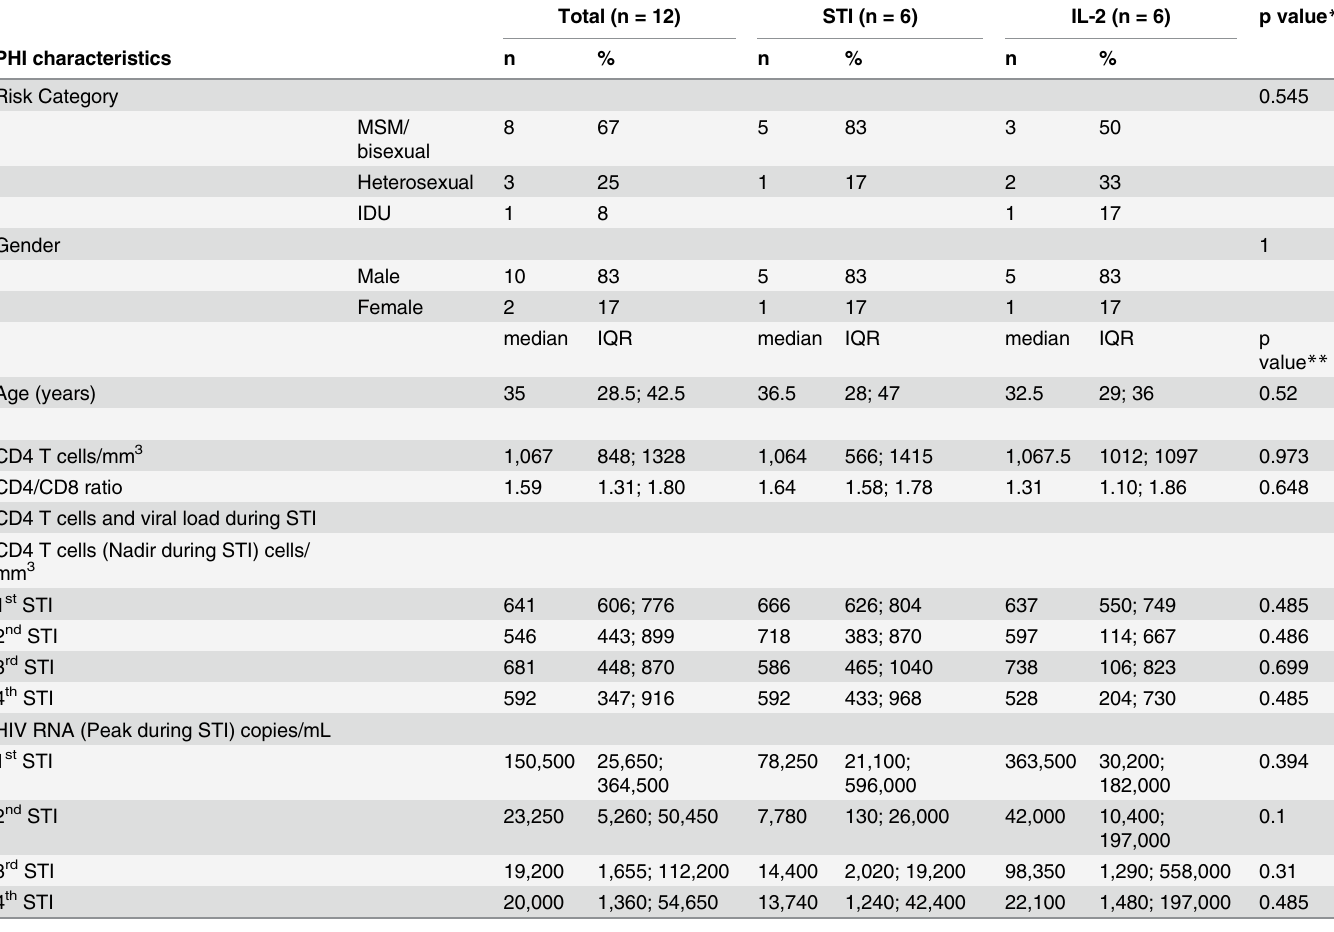
Table 1. Baseline characteristics at inclusion and CD4 T cells and viral load during